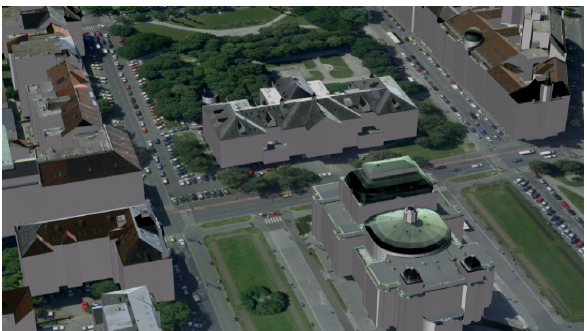
Figure 5: A 3D city model of Zagreb, Croatia made by Geofoto, intended for 3D printing combining CityGML LODs 1 and 3 in single objects, and varying in texture. Courtesy of the